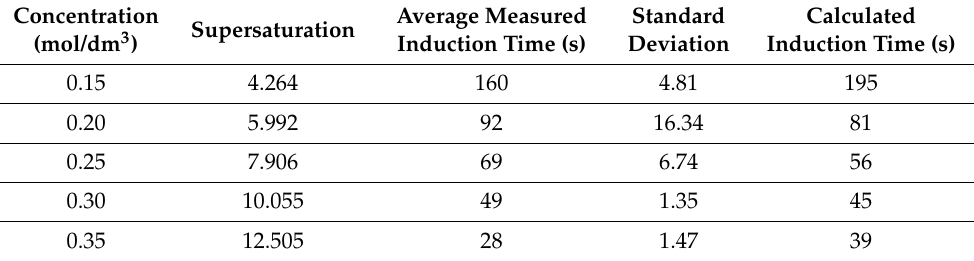
Table 10. Comparison of the calculated induction times with measured